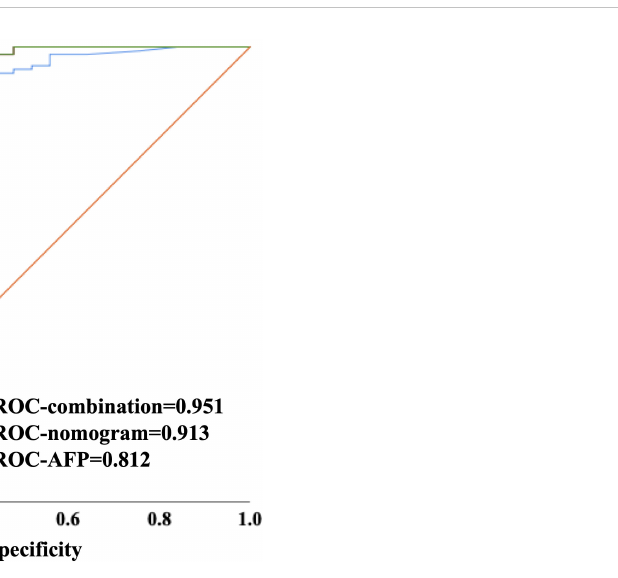
FIGURE 4 ROC curves showing diagnostic value of nomogram combining with AFP in distinguishing HCC patients from liver cirrhosis